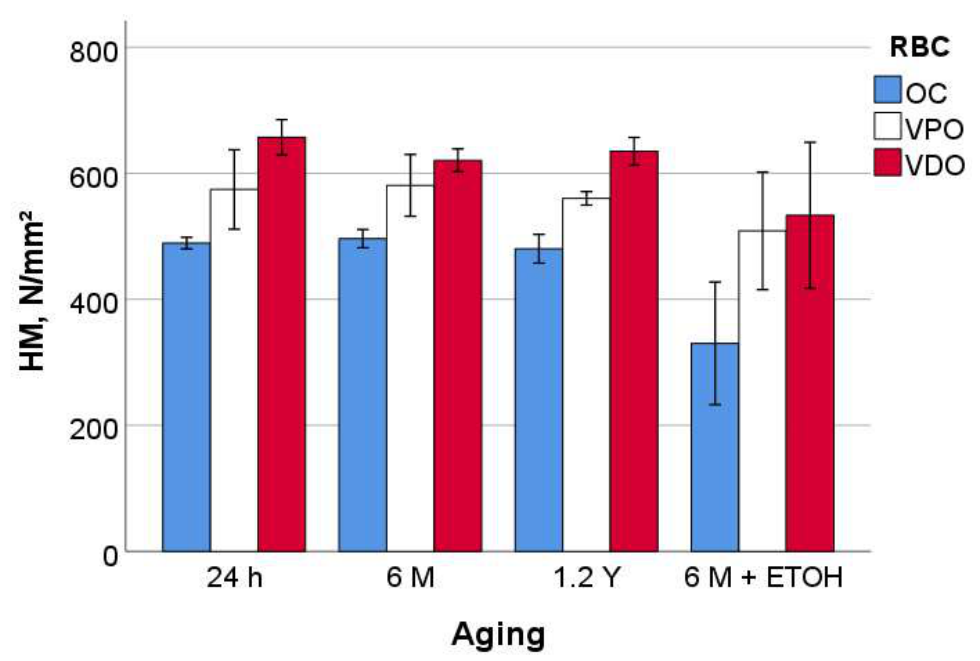
Figure 2. Martens hardness (HM) as a function of RBC and aging method (mean values with 95% confidence interval).